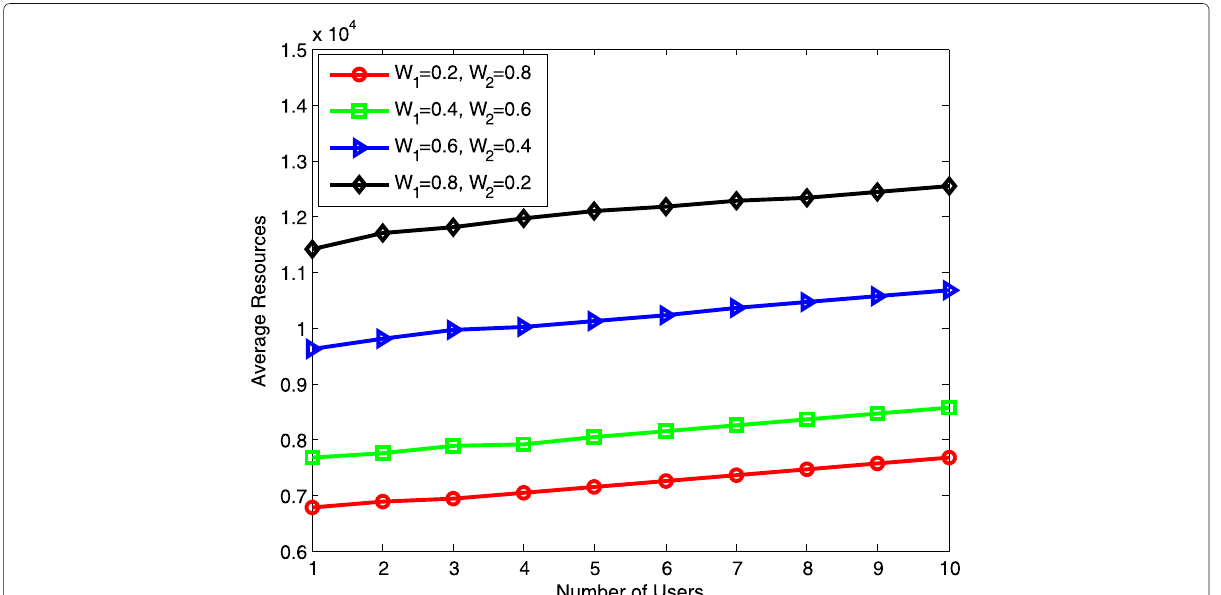
Fig. 5 Average resource requirement results with different weight combinations and number of devices